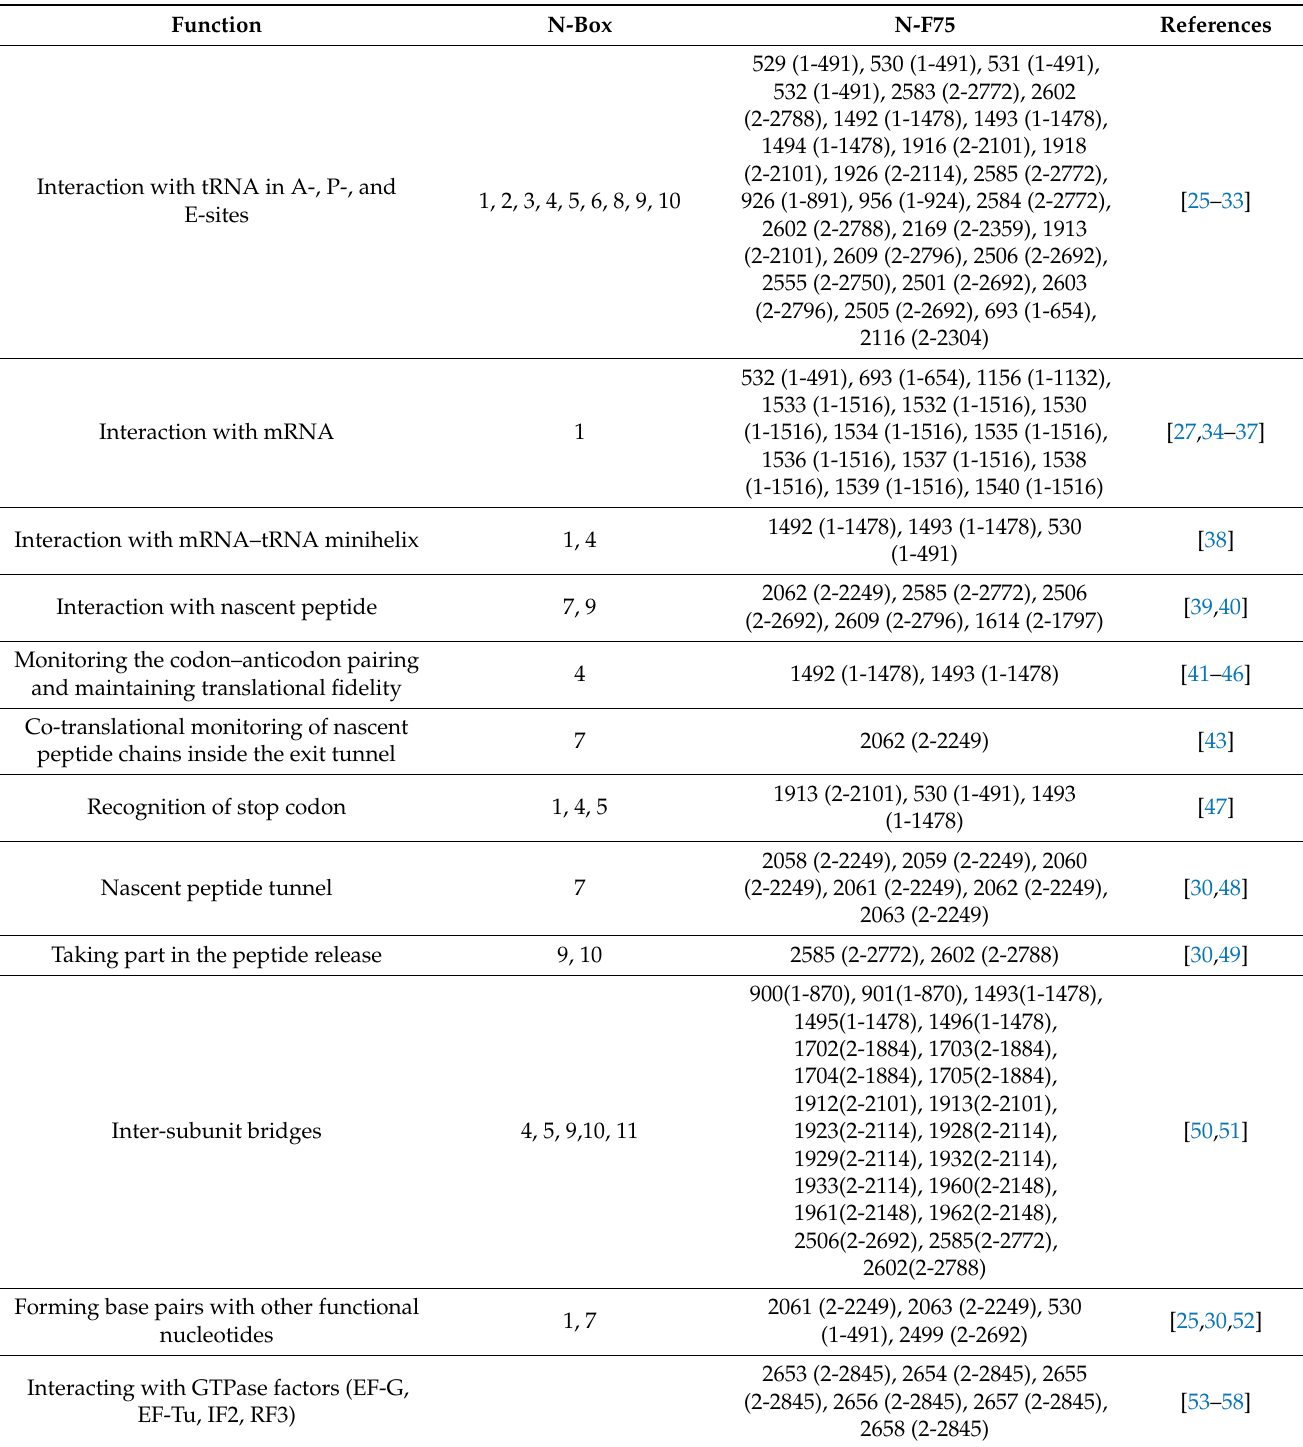
N-Box: Boxed number corresponding to that in Figure 5. N-F75: Functional nucleotide sites contained in the 75 short fragments. The part outside the bracket refers to the functional nucleotide set in the rRNAs of E. coli . The part inside the bracket is the code number of the corresponding short fragment’s first nucleotide. The number before ‘-’ is the location, where ‘1’ is for 16S rRNA and ‘2’ is for 23S rRNA. The number after ‘-’ refers to the number of ancestral sequences with